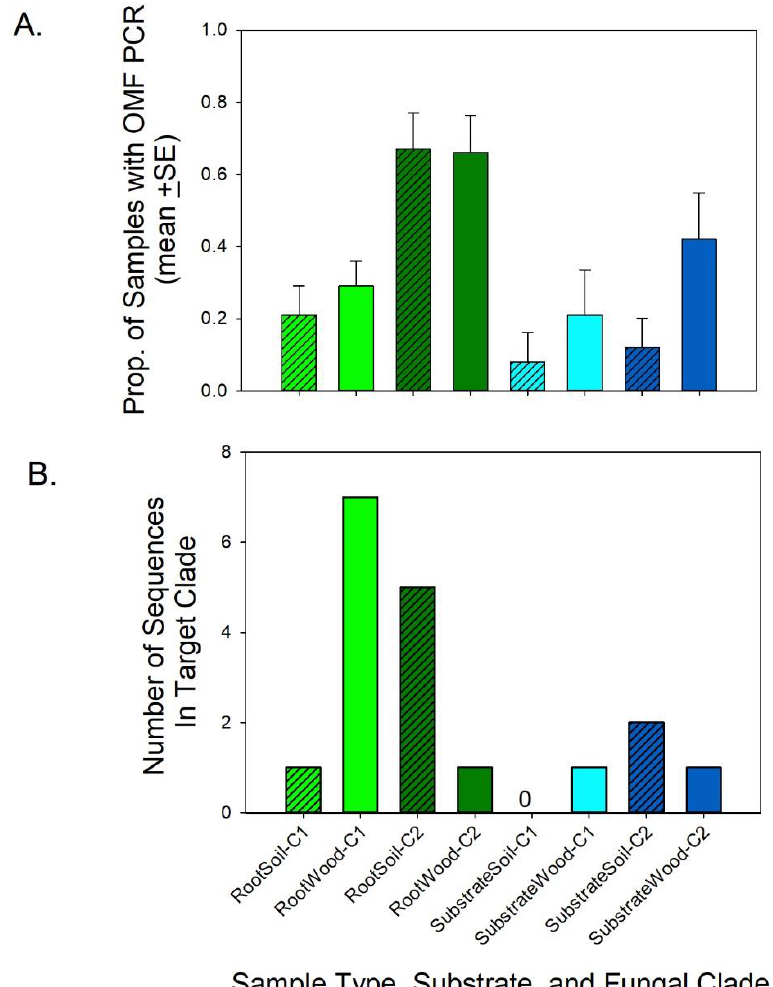
Figure 2. Prevalence of protocorm fungi. ( A ) Proportion of samples from roots (green bars) and substrates (blue bars) adjacent to roots of mature T. discolor plants growing in substrate rich in decomposing wood (solid bars) or bare soil (hatched bars) and ( B ) number of DNA sequences obtained from roots and substrates using PCR primers specific to Clade 1 (light green and light blue bars) and Clade 2 (dark green and dark blue bars). X-axis labels indicate the sample type (Root or Substrate), the substrate type (Wood or Soil), and the fungal clade presented (Clade 1 (C1) or 2 (C2)). Considering positive PCR products, adult plant roots were similarly likely to have positive PCR product from the two primers in wood and soil substrates (Clade 1: 19/51, Clade 2: 21/51; p = 0.5, Figure 2A). Roots of adult orchids that were growing in decomposing wood more frequently had Clade 1 protocorm fungi detected using sequences. However, based on the sequences obtained, many of the PCR products, especially those using the Clade 2 primers, may have belonged to taxa outside of the target clades. Although